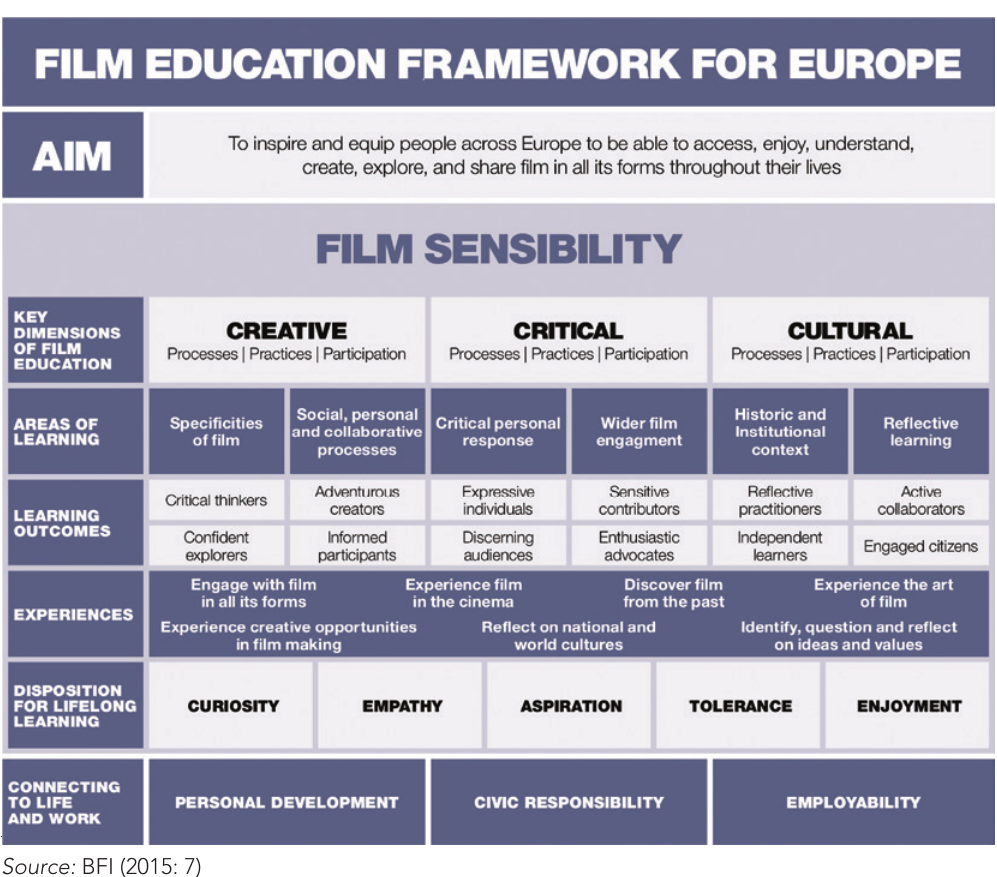
figure 1: film education framework for